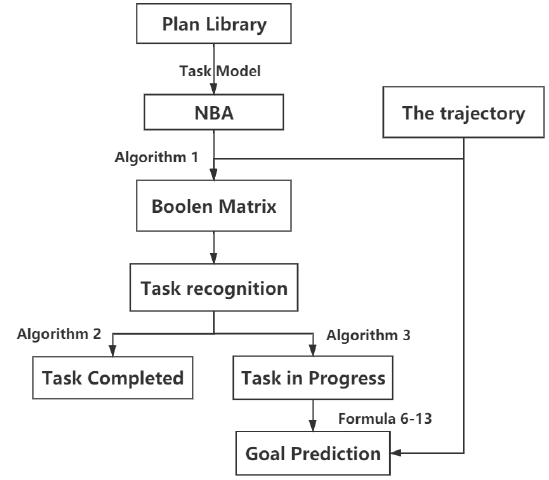
Figure 1. Multi-agent plan recognition